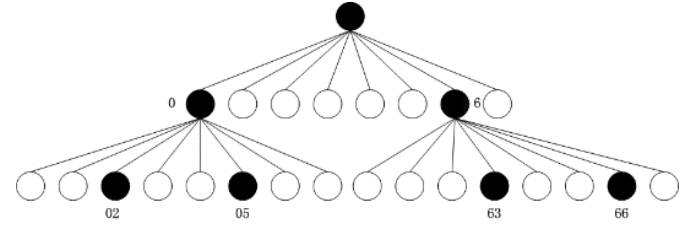
Figure 7. The quadtree structure.